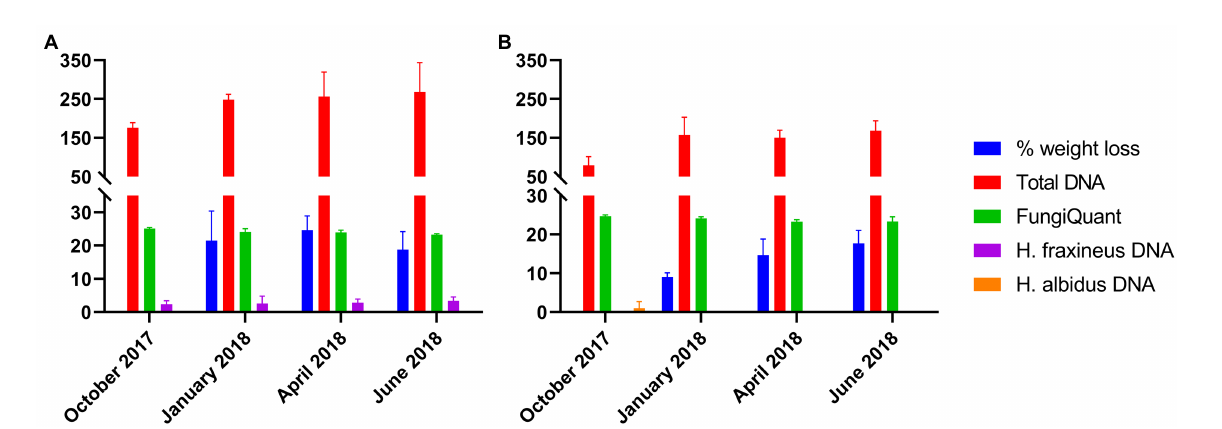
FIGURE 1 Petiole weight loss (%), total DNA amount (measured by Nanodrop, ng of DNA/mg of tissue), estimate of fungal DNA level (measured by FungiQuant qPCR, Cq value) and DNA amounts (ng of DNA/mg of tissue) of Hymenoscyphus fraxineus and Hymenoscyphus albidus as estimated by species- specific qPCR assays over the four time points. The data was collected from samples from Norderås (A) and Stjørdal (B) . Bars indicate standard deviation, n = 3 per time